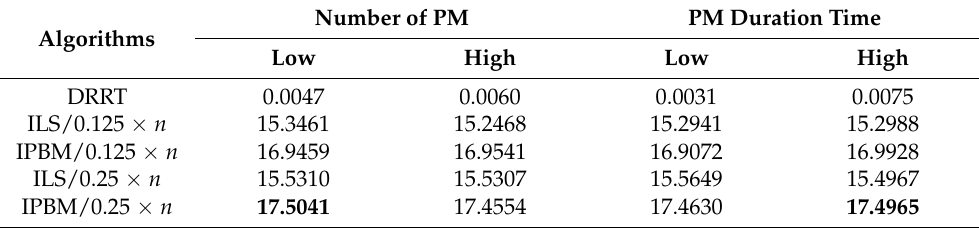
Table 6. Results for different number of orders and number of machines (in RPD).